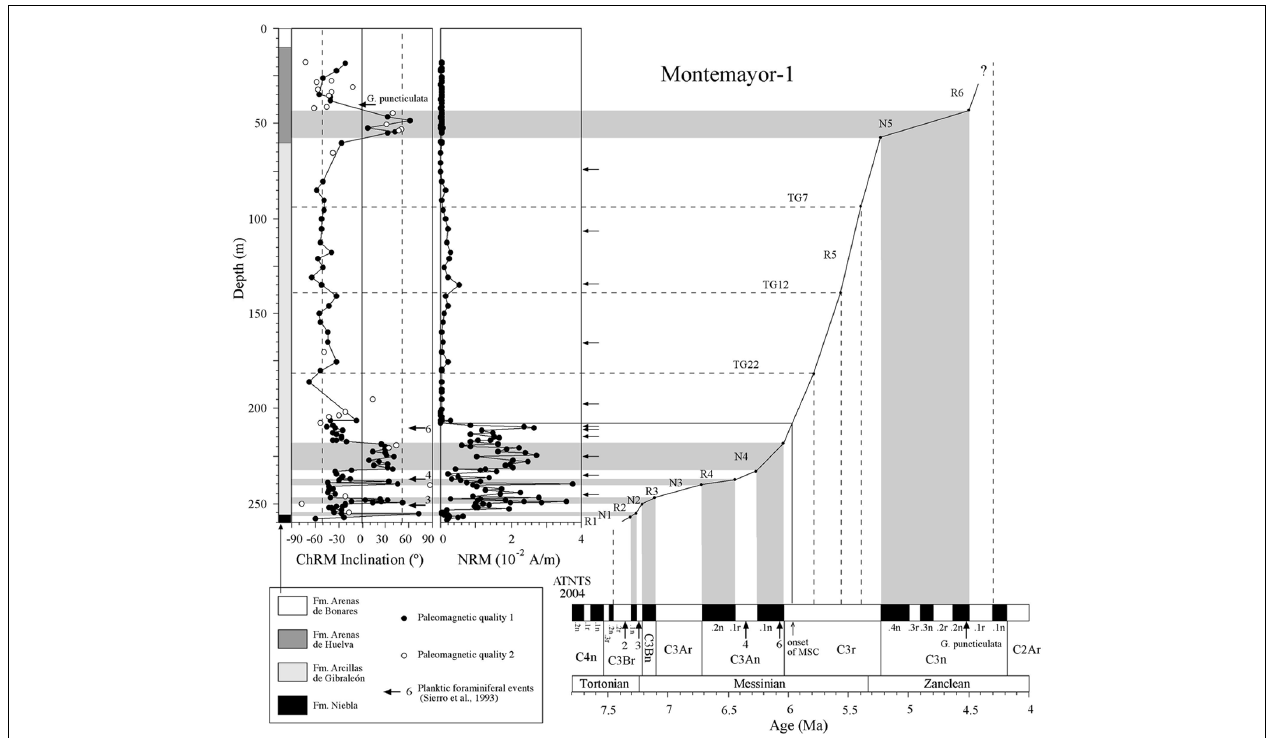
FIGURE 4 | Magnetostratigraphic and biostratigraphic results from the Montemayor-1 borehole, and correlation of polarity intervals withATNTS (Lourens etal., 2004). Additional tie points for the age model are provided by identification of glacial-interglacial stagesTG 7, 12, and 22 from oxygen